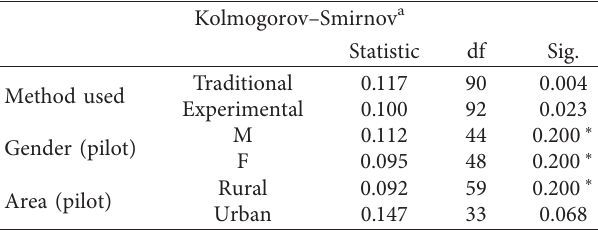
Table 4: Tests of normality of the posttest according to the method, gender (pilot), and area (pilot).